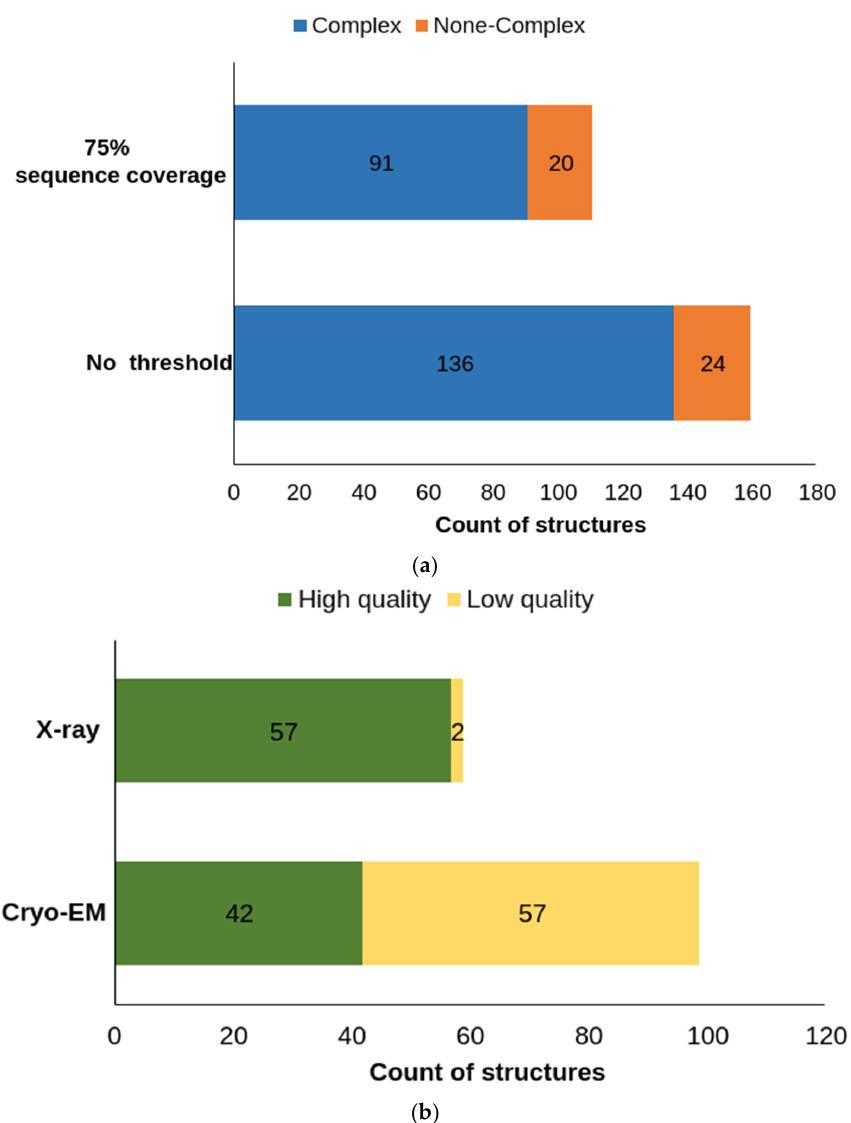
Figure 5. Composition of PDB structure. ( a ) in total, 160 PDB structures are retrieved for all 48 ABC ‐ transporters, in which 136 concatenates (blue fraction) contain crystalized small molecules, 24 not (orange fraction). A threshold of 75% sequence coverage filters out 59 structures, leaving 101 experimentally solved human ABC structures. Among these, 20 are without and 91 are with a small molecule complexed. ( b ) For the total 160 PDB structures, 99 structure possess a resolution value lower than 3.5 Å (green fraction), among which 57 are solved by X ‐ ray, and 42 are from cryo ‐ EM. Apart from these two methods, one structure was solved by NMR, which is not included in the bar chart.